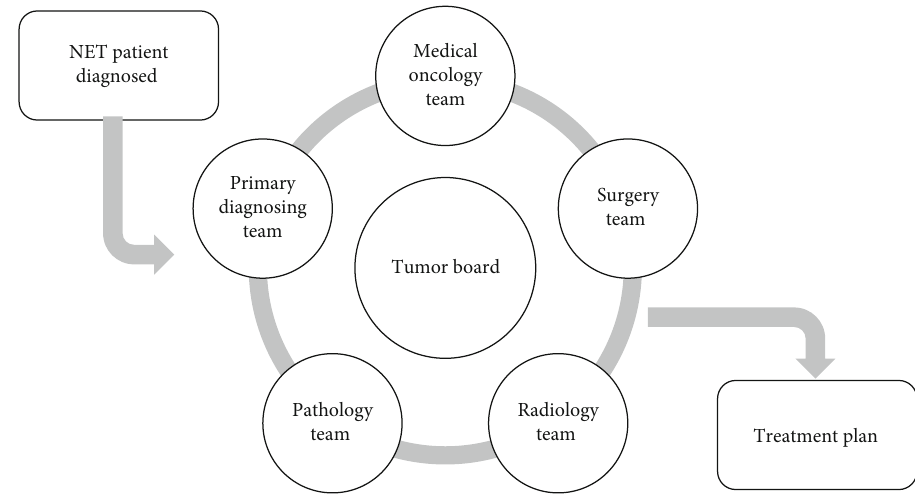
Figure 4: The NET tumor board and treatment plan